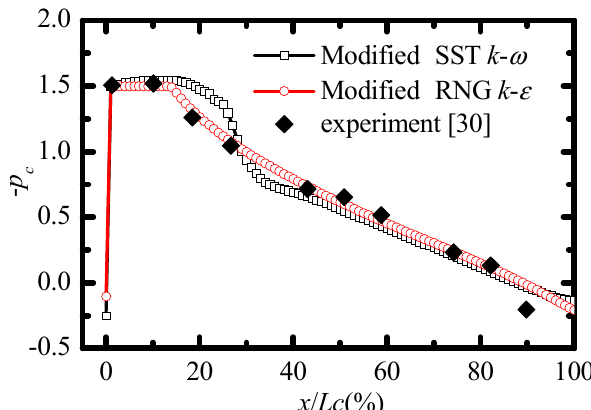
Figure 11. Pressure coefficient distribution of the NACA0015 hydrofoil at 70° С .